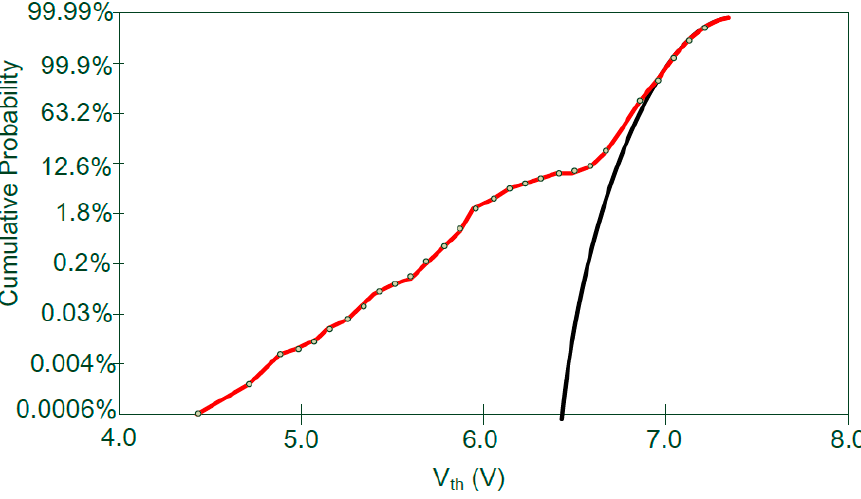
Figure 1. Cumulative distributions of threshold voltages for exposed cells [1].